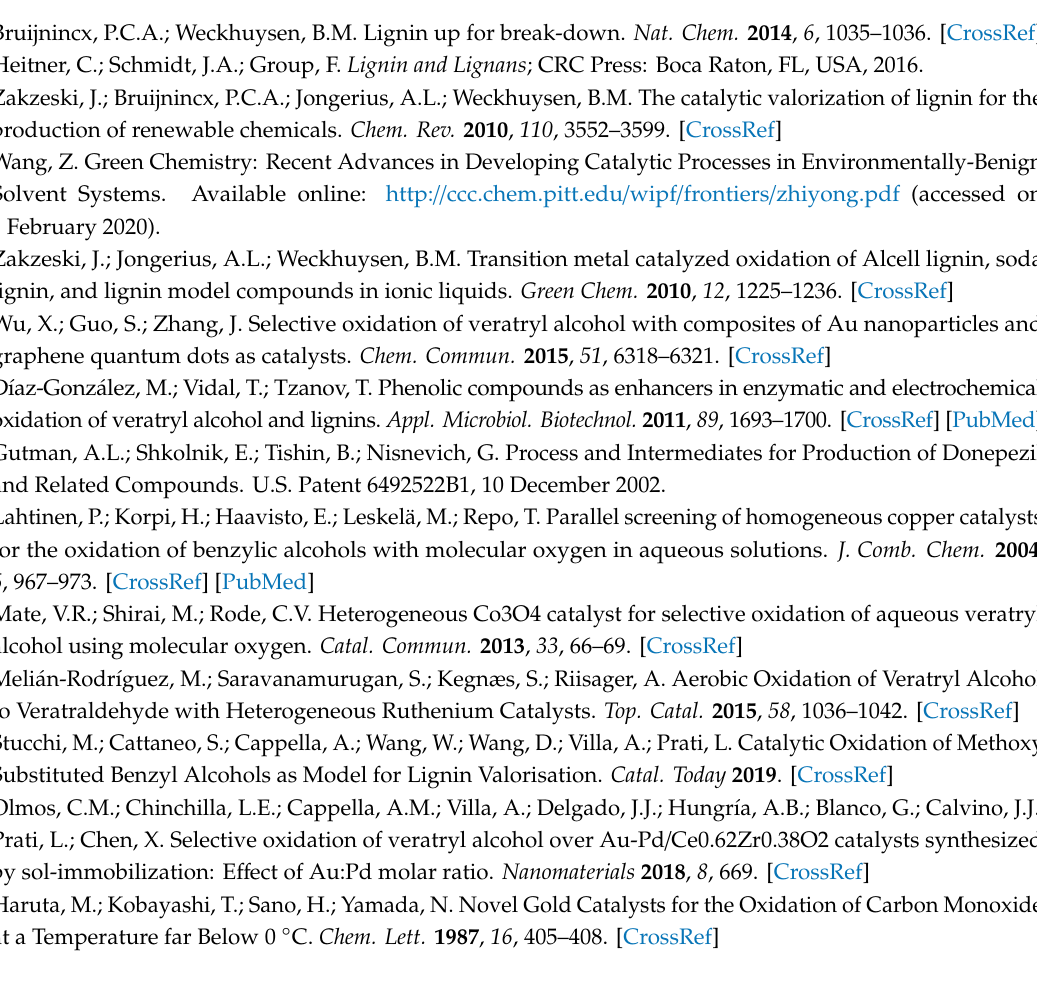
Figure S1: Cu 2p deconvolution for ( A ) Au 4 Cu 1 ( B ) Au 1 Cu 1 and ( C ) Au 1 Cu 4 C-supported catalysts, Figure S2: Cu 2p deconvolution for ( A )